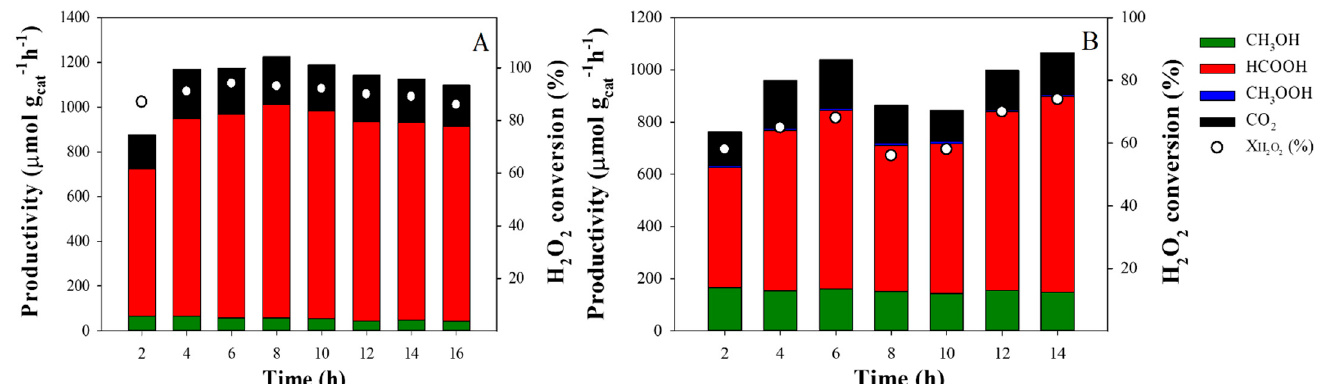
Figure 7. Continuous aqueous phase oxidation of methane with H 2 O 2 in a flow reactor over 0.51%Fe/ZSM-5 ( A ), and 0.56%Cu-0.30%Fe/ZSM-5 ( B ). Reaction conditions: P CH4 = 21 bar, F CH4 = 50 mL/min, [H 2 O 2 ]= 0.123 mol/L, F H2O2 = 0.25 mL/min, W cat . = 0.2 g, Temperature = 50